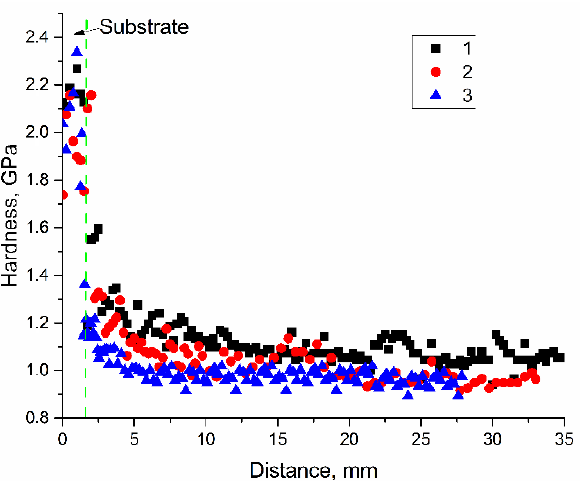
Figure 16. Microhardness profiles as measured along the wall height. EBAM regime: 1, 0.21 kJ/mm; 2, 0.255 kJ/mm; 3, 0.3 kJ/mm.